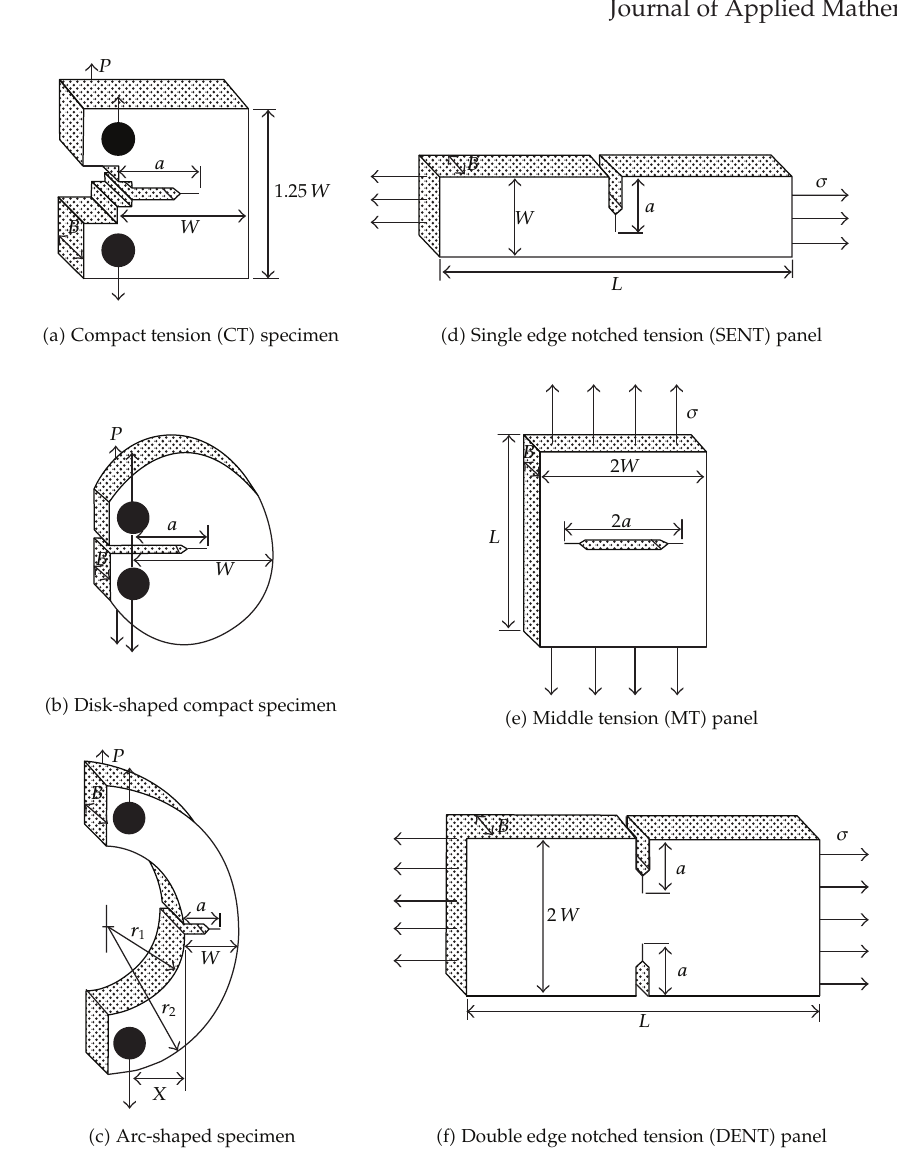
Figure 6: Specimens used for analysis (cid:6) 23 (cid:7)